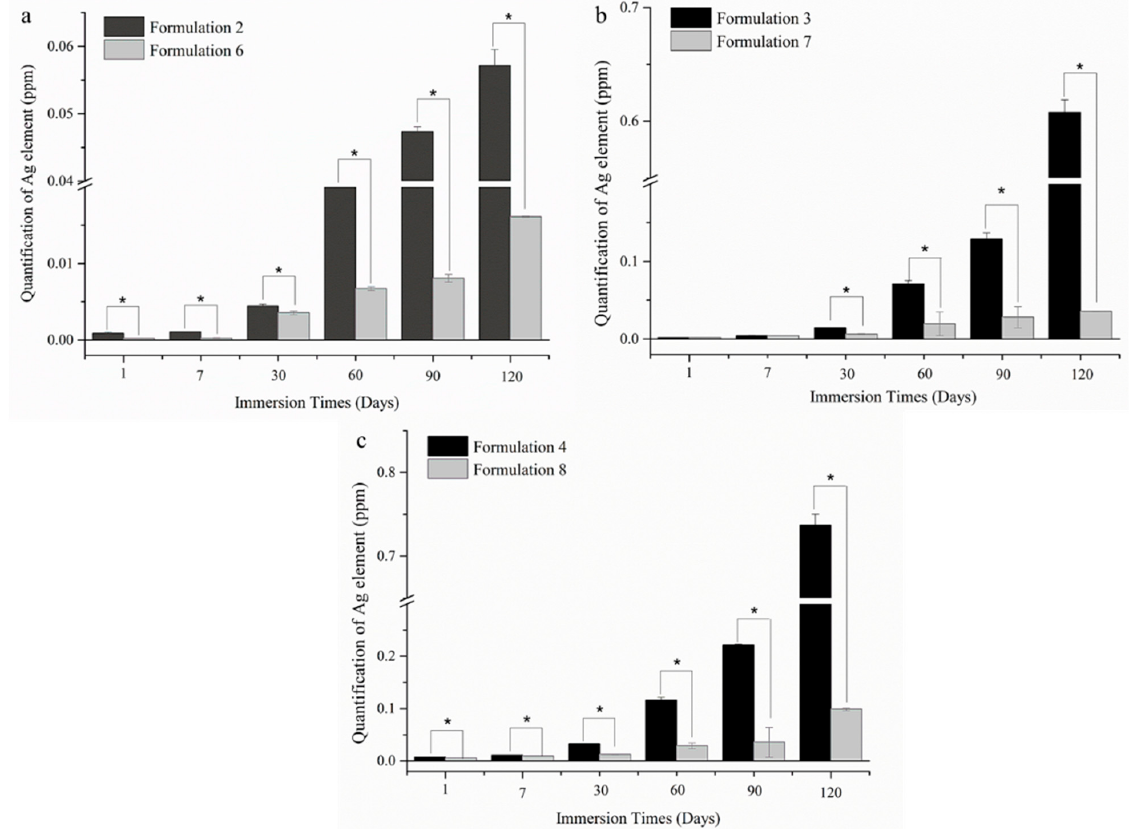
Figure 7. Comparison of the amount of silver ions released from the same AgNPs-containing formulation coating at 1 day, 7 days, 30 days, 60 days, 90 days and 120 days. F2 compared with F6 ( a ); F3 compared with F7 ( b ); and F4 compared with F8 ( c ) (* Indicates statistical significance at p < 0.05 (95% confidence interval)).